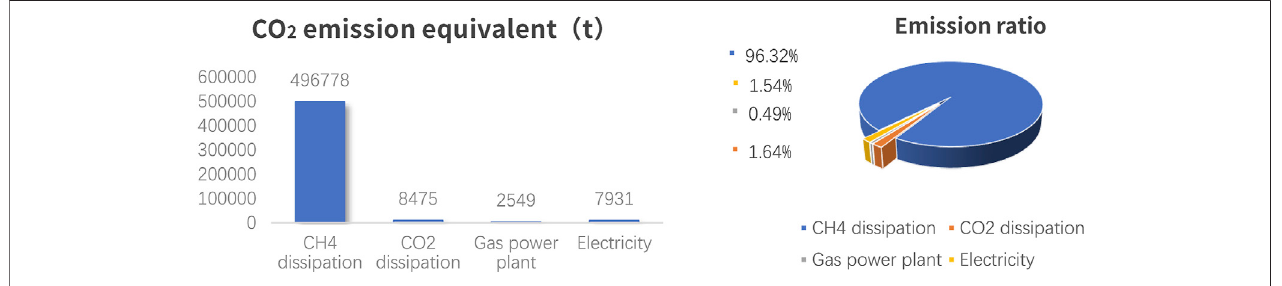
FIGURE 7 | Carbon emission by source and emission proportion of Zhongheng coal